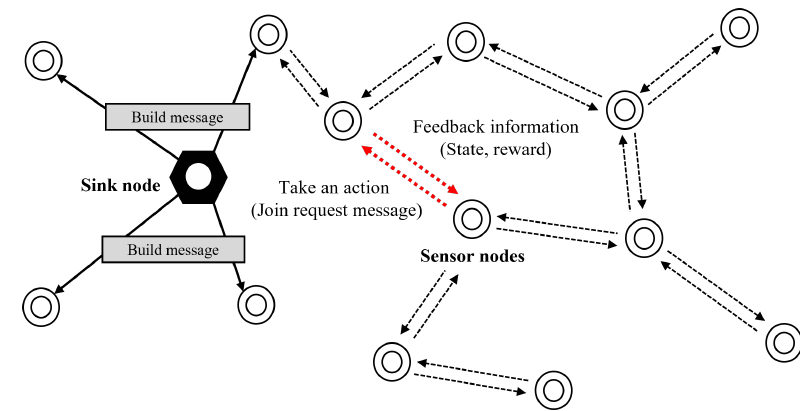
Figure 4. An example: RL-based parent